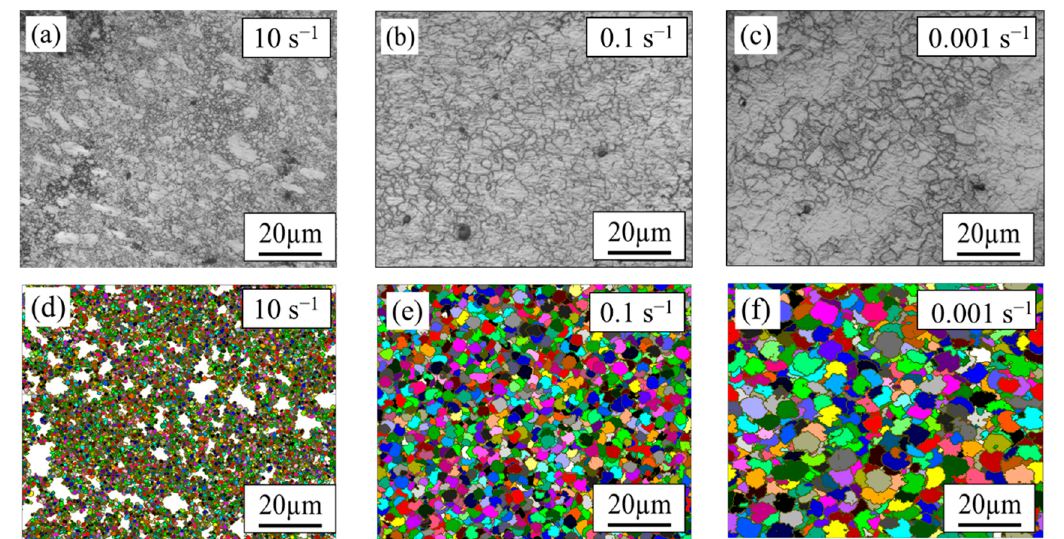
Figure 8. Microstructural evolution under different strains of ( a ) 0.1, ( b ) 0.2, ( c ) 0.5 and ( d ) 0.9 in CA simulation.